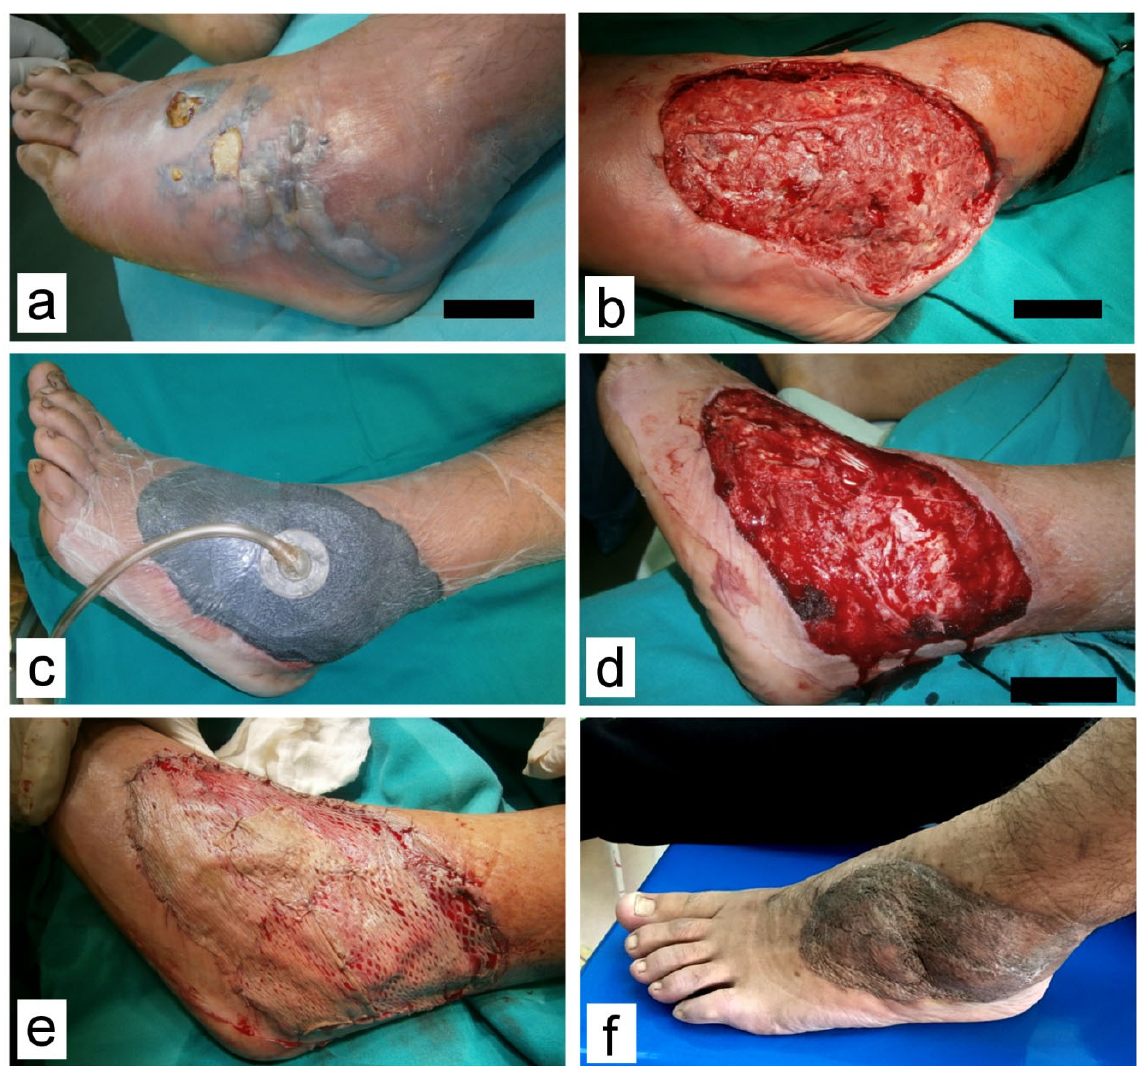
Figure 2. Wound on the right foot with necrotizing fasciitis caused by a streptococcus β -hemolithicus infection. ( a ) Prior to debridement; ( b ) Soft tissue defect after debridement 5 days post injury; ( c ) Marked decrease in soft tissue swelling during V.A.C. ® treatment; ( d ) Granulation tissue after 14 days on V.A.C. ® . Note adhered parts of black foam that had to be surgically removed; ( e ) Wound was covered with STSG after 20 days; ( f ) At the 2-month follow-up visit.